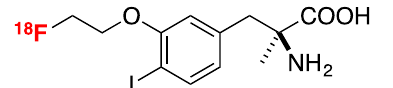
Fig. 1 Chemical structure of ( S )-2-amino-3-[3-(2- 18 F-fluoroethoxy)-